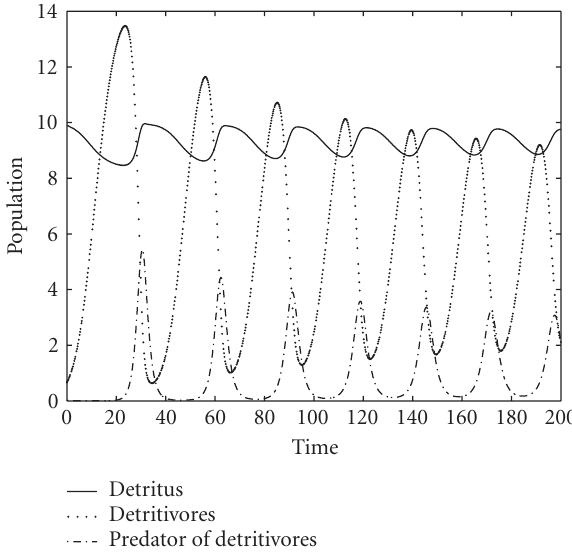
Figure 6.2. Solution of (5.1) with T 1 = 2 . 5 > T + 1 and T 2 = . 8 > T + 2 , other parameters are same as de- scribed in Section